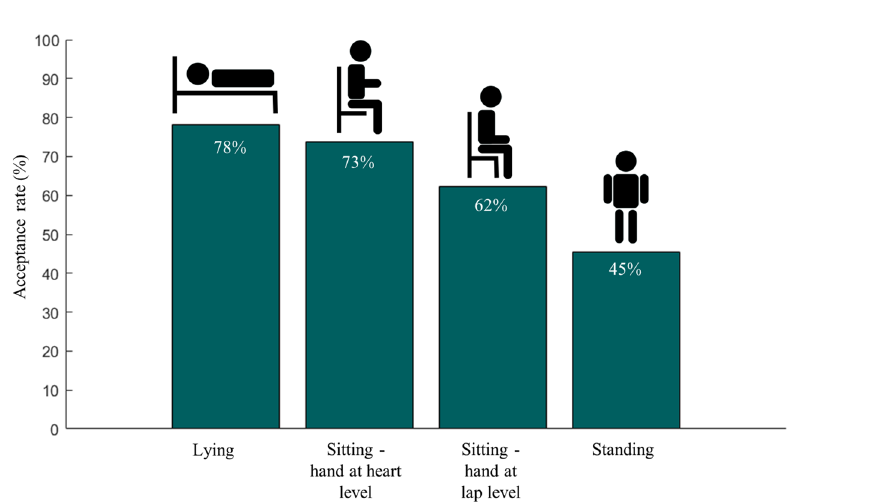
Figure 5. Acceptance rate of the Pulse Wave Analysis algorithms of Aktiia bracelet for each body position: percentage of time for which the recorded optical signals could be analyzed to generate a SBP and a DBP